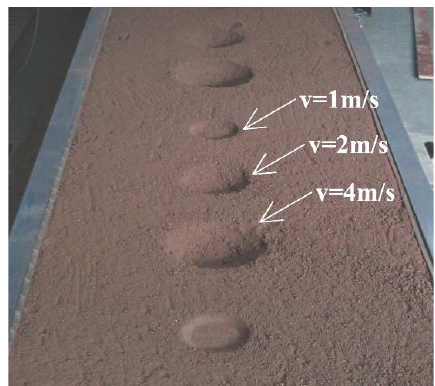
Figure 11: Impact craters on TJ-1 soil site ( 𝐷 𝑟 = 60%).